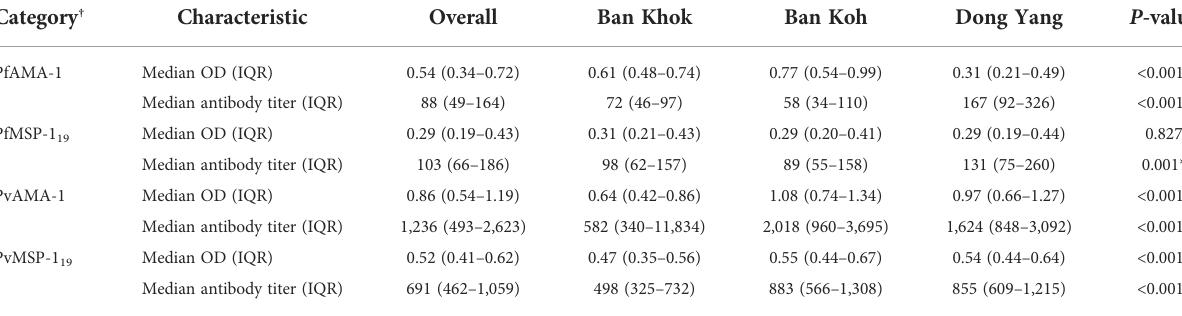
TABLE 3 Malaria species – speci fi c antibody responses and seroconversion